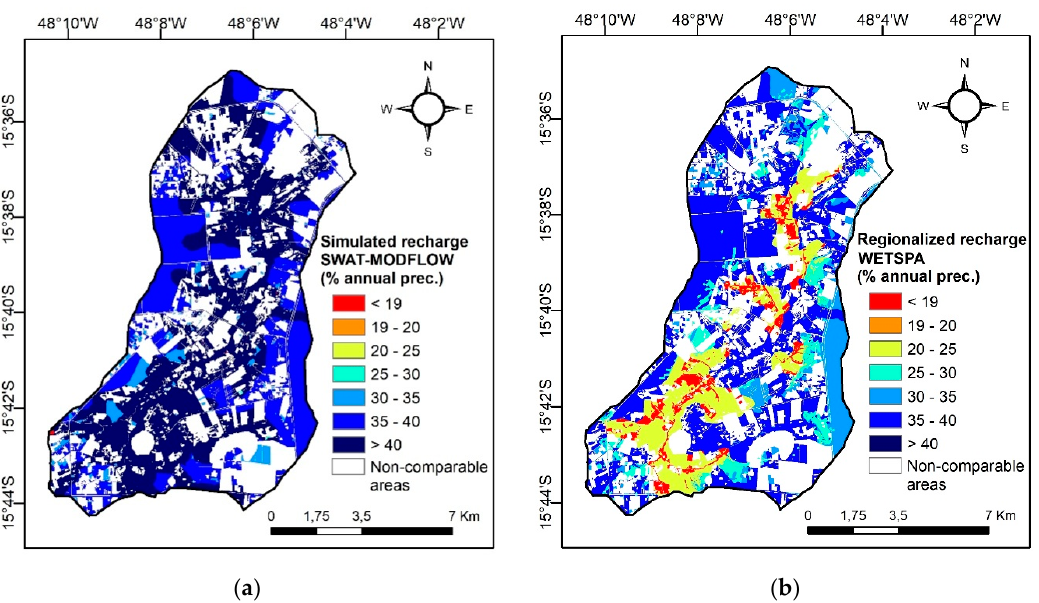
Figure 4. ( a ) Spatial distribution of the simulated recharge; ( b ) Spatial distribution of the regionalized recharge.